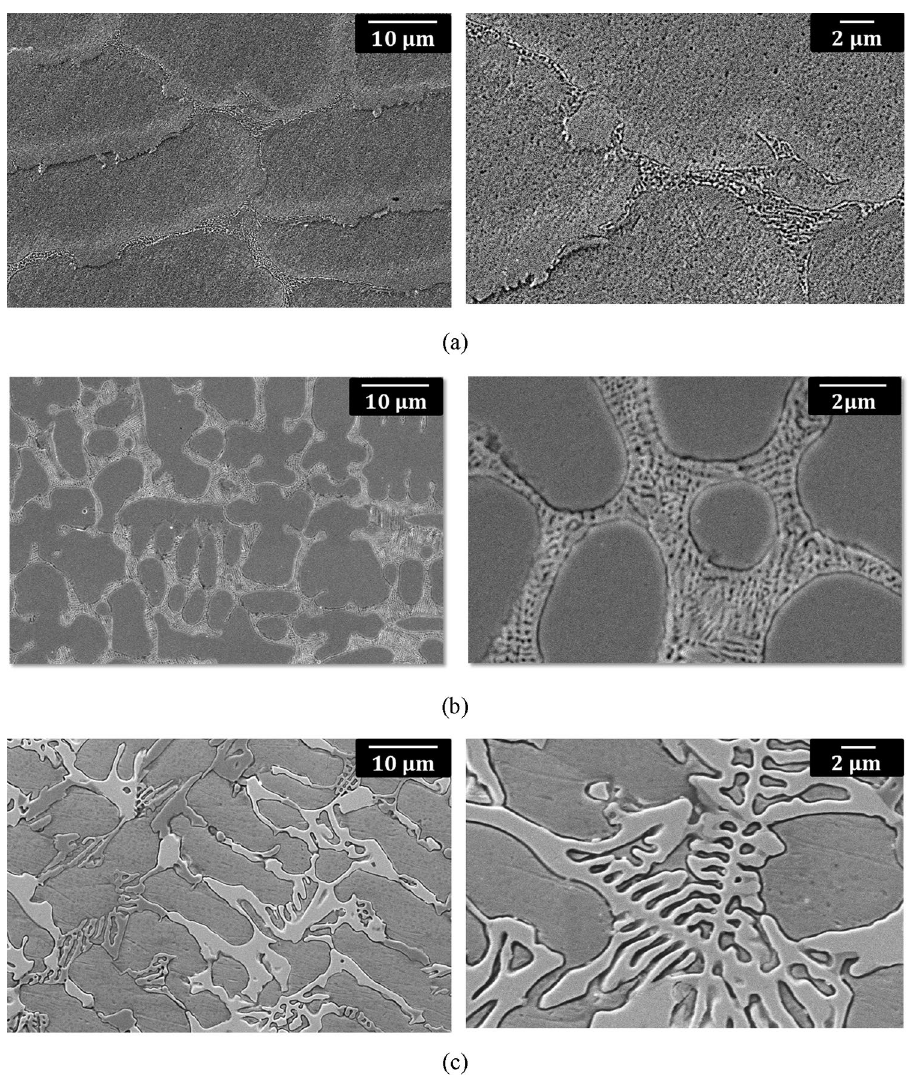
Figure 3. Example scanning electron micrographs of composite samples prepared from ( a ) CoCrFeNi-5 wt% WC ( b ) CoCrFeNi-10 wt% WC ( c ) CoCrFeNi-20 wt% WC. A eutectic microstructure consisting of an alloyed carbide phase (white) and a matrix phase (grey) can be seen, with an obvious increase in the eutectic phase volume fraction with increasing WC